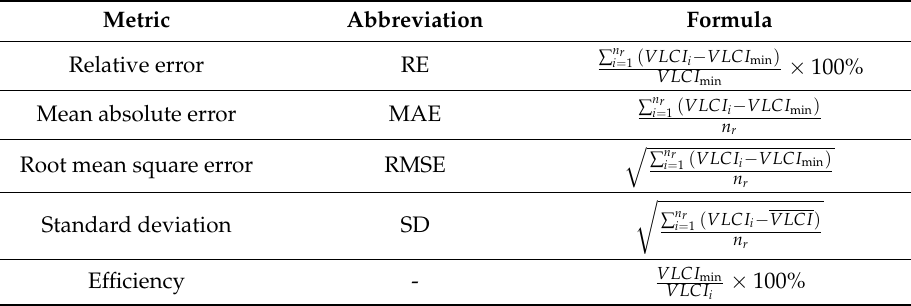
Table 8. Quality indexes employed for evaluating the performance of the proposed